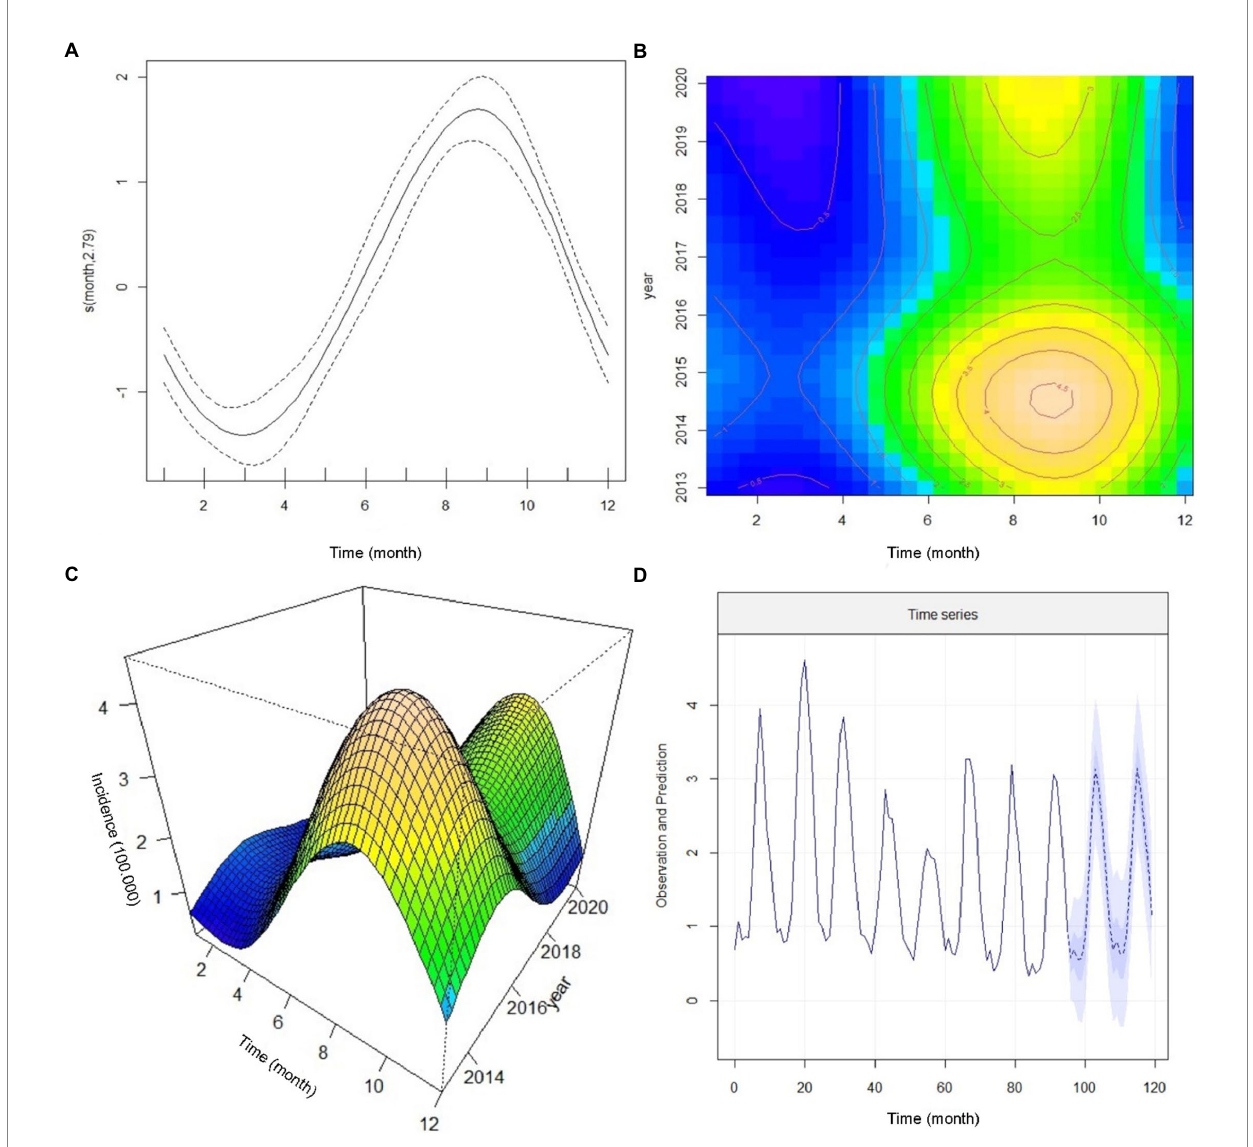
FIGURE 3 The annual incidence trend of cutaneous leishmaniasis in various provinces of Iran by the generalized additive mixed model (GAMM), 2013–2020. (A) Confirmation of a non-linearity model of incidence trends (B) a Contour analysis-based seasonal cycle displaying the incidence trends, (C) A 3-dimensional monthly-annual image of the incidence trends, and (D) Predicting the trend in the number of new cutaneous leishmaniasis cases from 2013 to